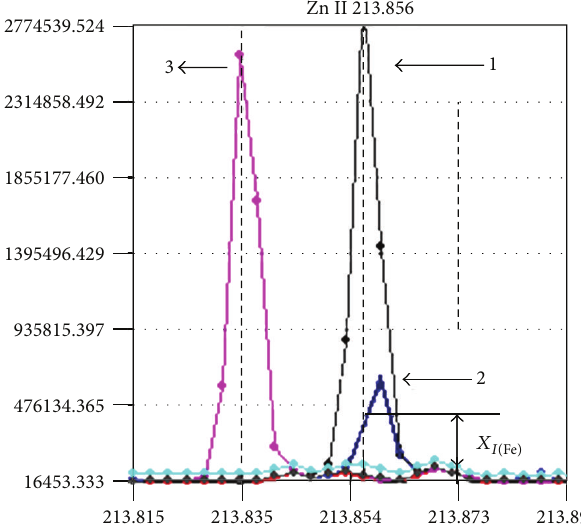
Figure 1: Spectral scans over the spectral region around the prominent line of Zn: central wavelength: 213.856 nm (Zn II line); interferents: Fe and Ti. (1) Central wavelength Zn II 213.856 nm, 1 𝜇 gmL −1 Zn in pure solvent; (2) interfering line: Fe 213.858 nm, concentration of Fe 2 mgmL −1 ; (3) interfering line: Ti 213.835 nm, concentration of Ti 2mg mL −1 ; [𝑋 𝐼 signals with respect to the wing background level [𝑋 𝑊